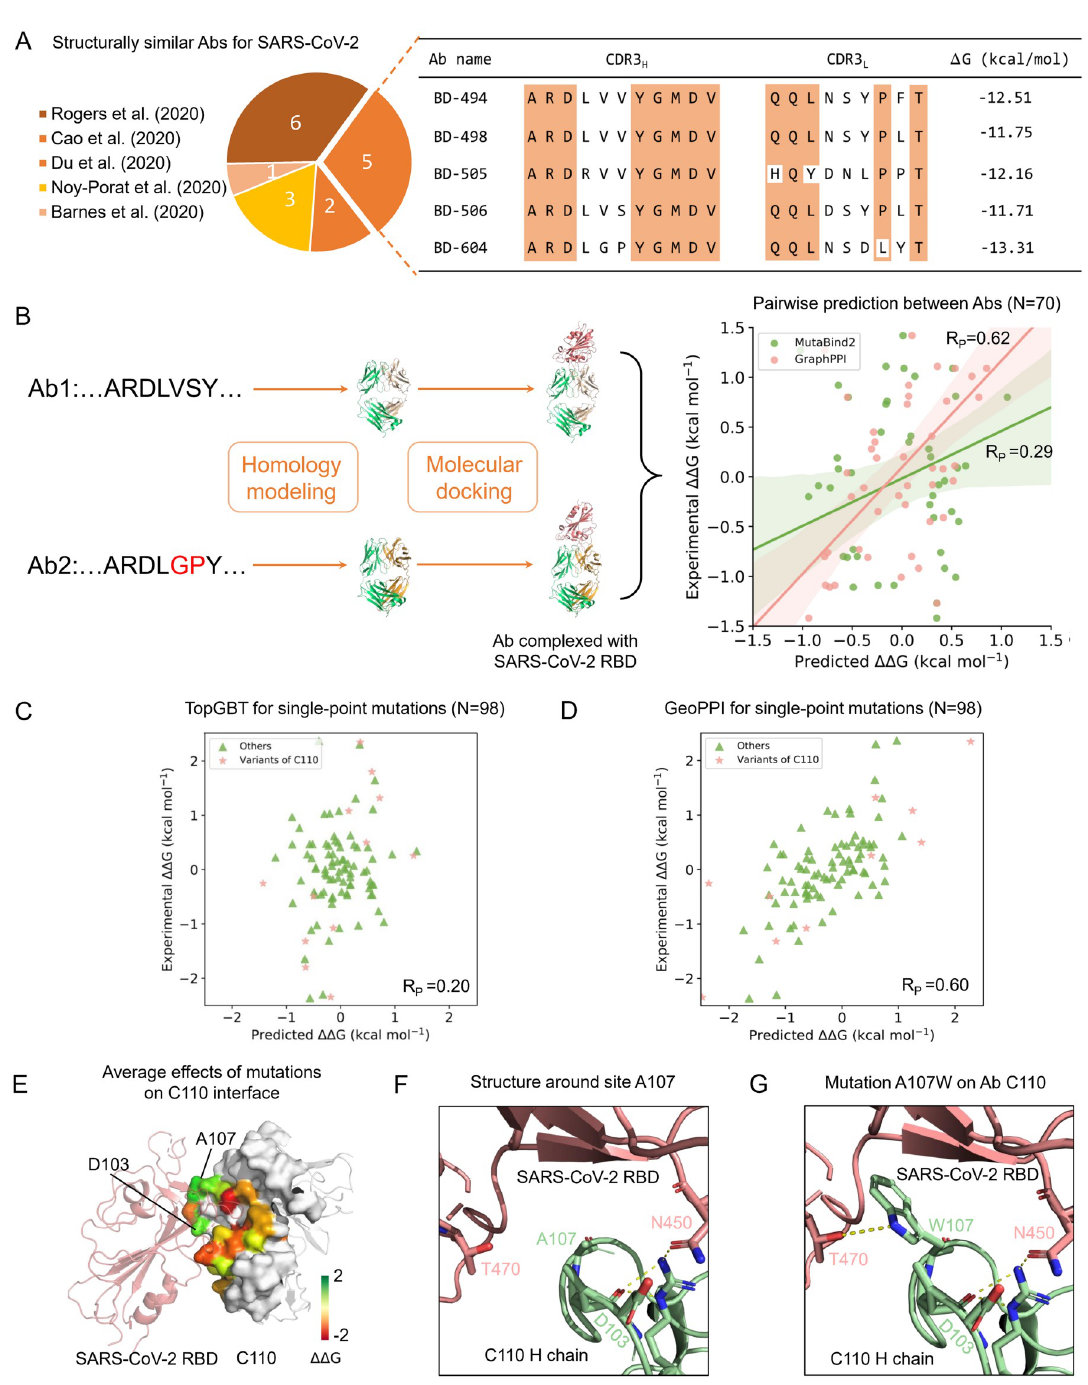
Fig 5. A case study on the antibodies (Abs) that neutralize SARS-CoV-2 by binding with the receptor-binding domain (RBD) of the spike protein. (A) Structurally similar SARS-CoV-2 neutralizing Abs and their CDR3 sequences (S9 Table). (B) Pairwise prediction performance between structurally similar Abs. The structures of these Abs are not solved and approximated by homology modeling. (C and D) Prediction performance of GeoPPI and TopGBT on the single-point mutations of SARS-CoV-2 complexed with individual Abs. This newly collected single-point mutation dataset (S10 Table) contains 98 mutations and corresponding binding affinity changes, including the complexes of SARS-CoV-2 bound to CR3022 [40], C002, C104, C105, C110, C121, C119, C135, C144 [41]. Among them, GeoPPI obtains the highest correlation on the variants of C110. (E) The average predicted affinity changes of the mutations on each residue on the interface of C110 complexed with SARS-CoV-2. (F) The structure around site A107 on C110. (G) The structure around site W107 on C110 with the mutation